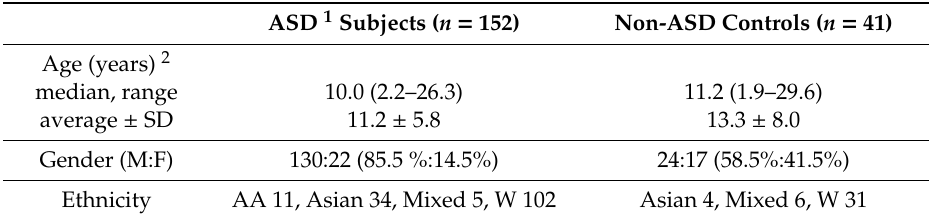
Table 9. Demographics of ASD subjects and non-ASD